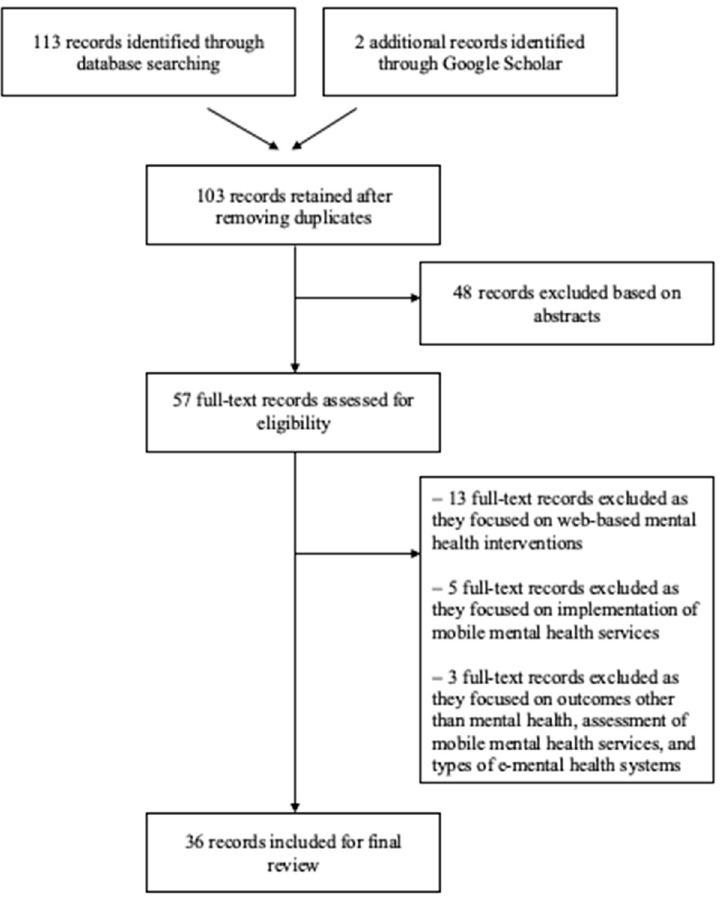
Figure 1. PRISMA diagram of reviews selected for inclusion in the umbrella